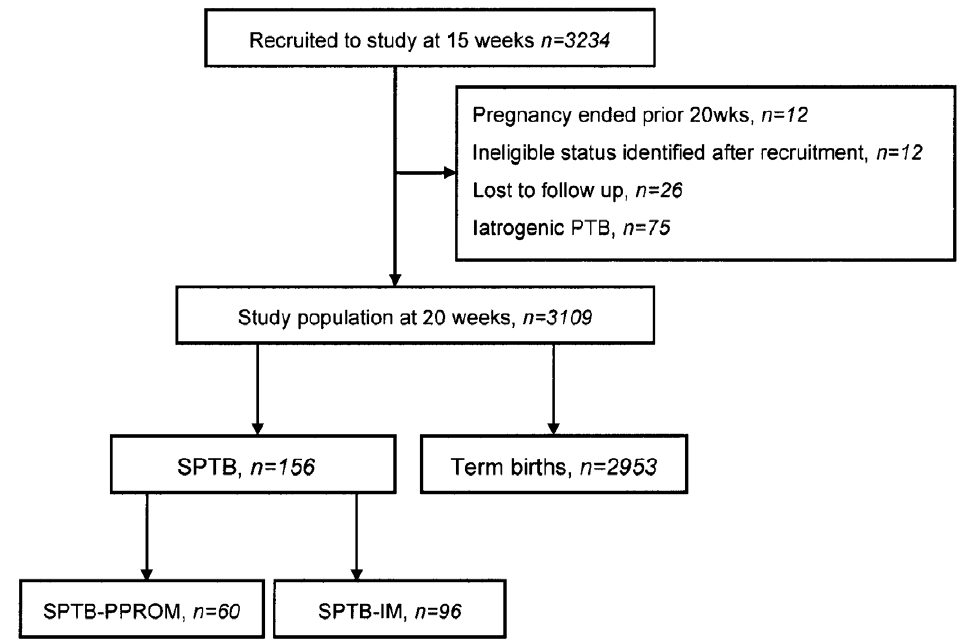
Figure 1. Participants recruited and study population.